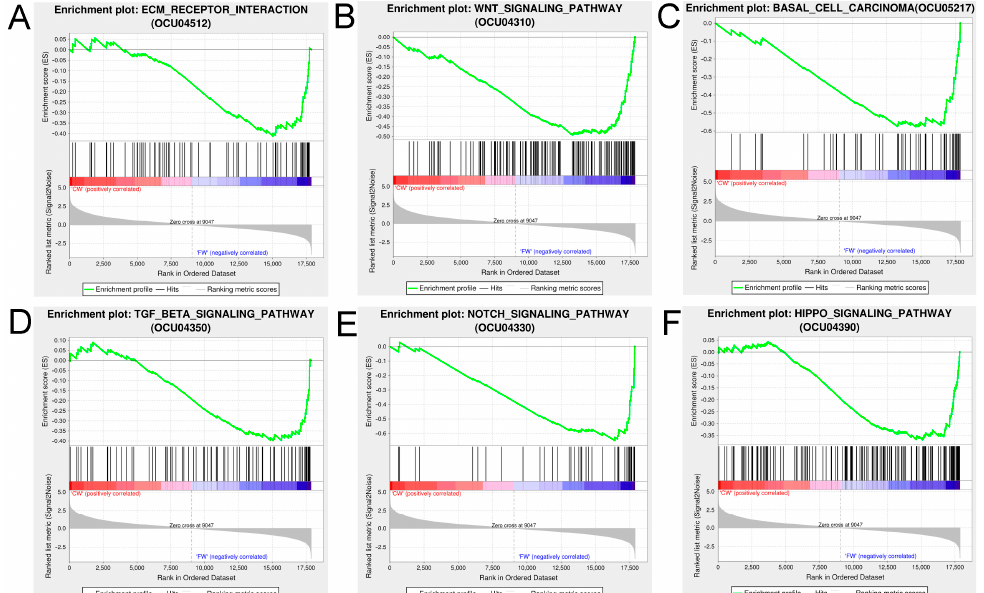
Figure 5. Gene set enrichment analysis was used to analyze the substantially enriched signaling. The enrichment scores of genes in the pathways were calculated using the GSEA algorithm. NOM p -value < 0.05 and |NES| > 1 were considered significant enrichment. ( A ) Extracellular matrix receptor interaction. ( B ) Wnt signaling. ( C ) Basal cell carcinoma. ( D ) TGF- β signaling. ( E ) Notch signaling. ( F ) Hippo signaling. Table 2. Gene sets enriched in the hair follicle of fine wool group.